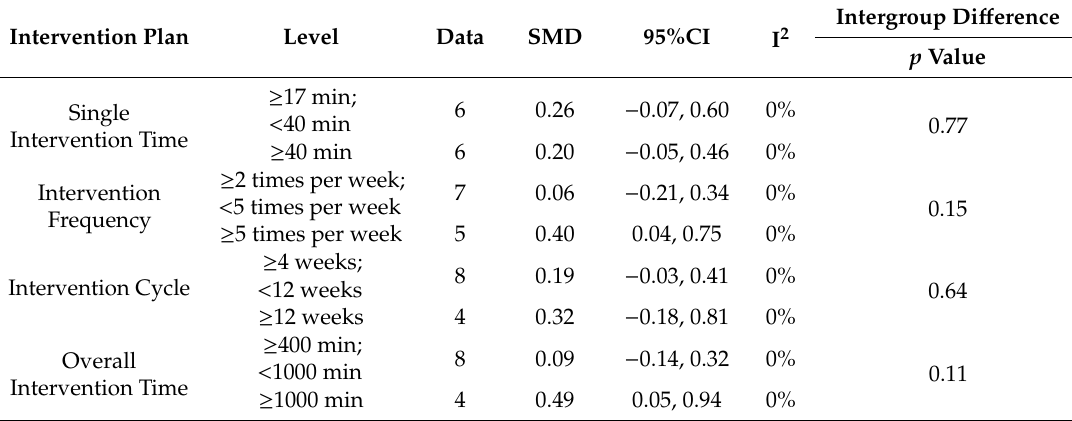
Table 3. Moderating E ff ects Analysis of VRGs Group’s Intervention Plan in Children with